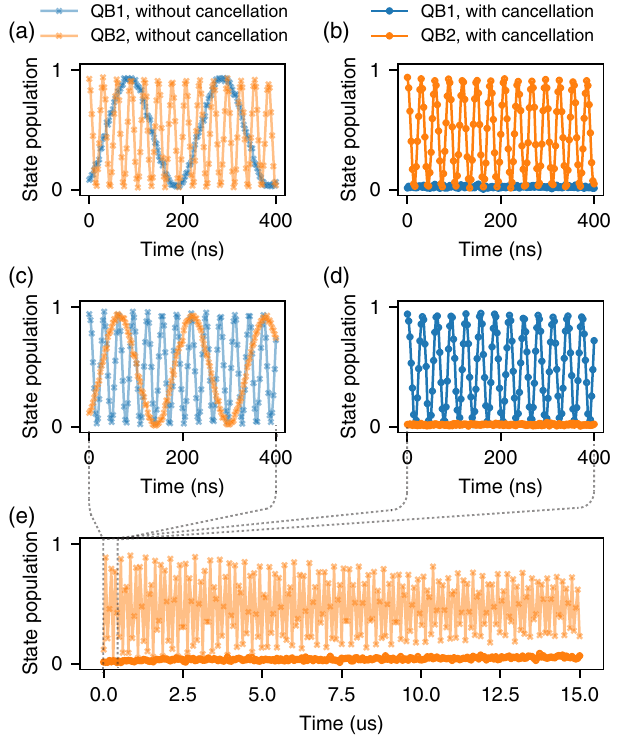
FIG. 22. Measurements and cancellation of a microwave cross talk. (a),(b) Rabi oscillations of QB1 (blue) and QB2 (orange) when driving through the QB2 local drive line. (c),(d) Rabi oscillations of QB1 (blue) and QB2 (orange) when driving through the QB1 local drive line. (e) Rabi oscillations of QB2 when driving through the QB1 local drive